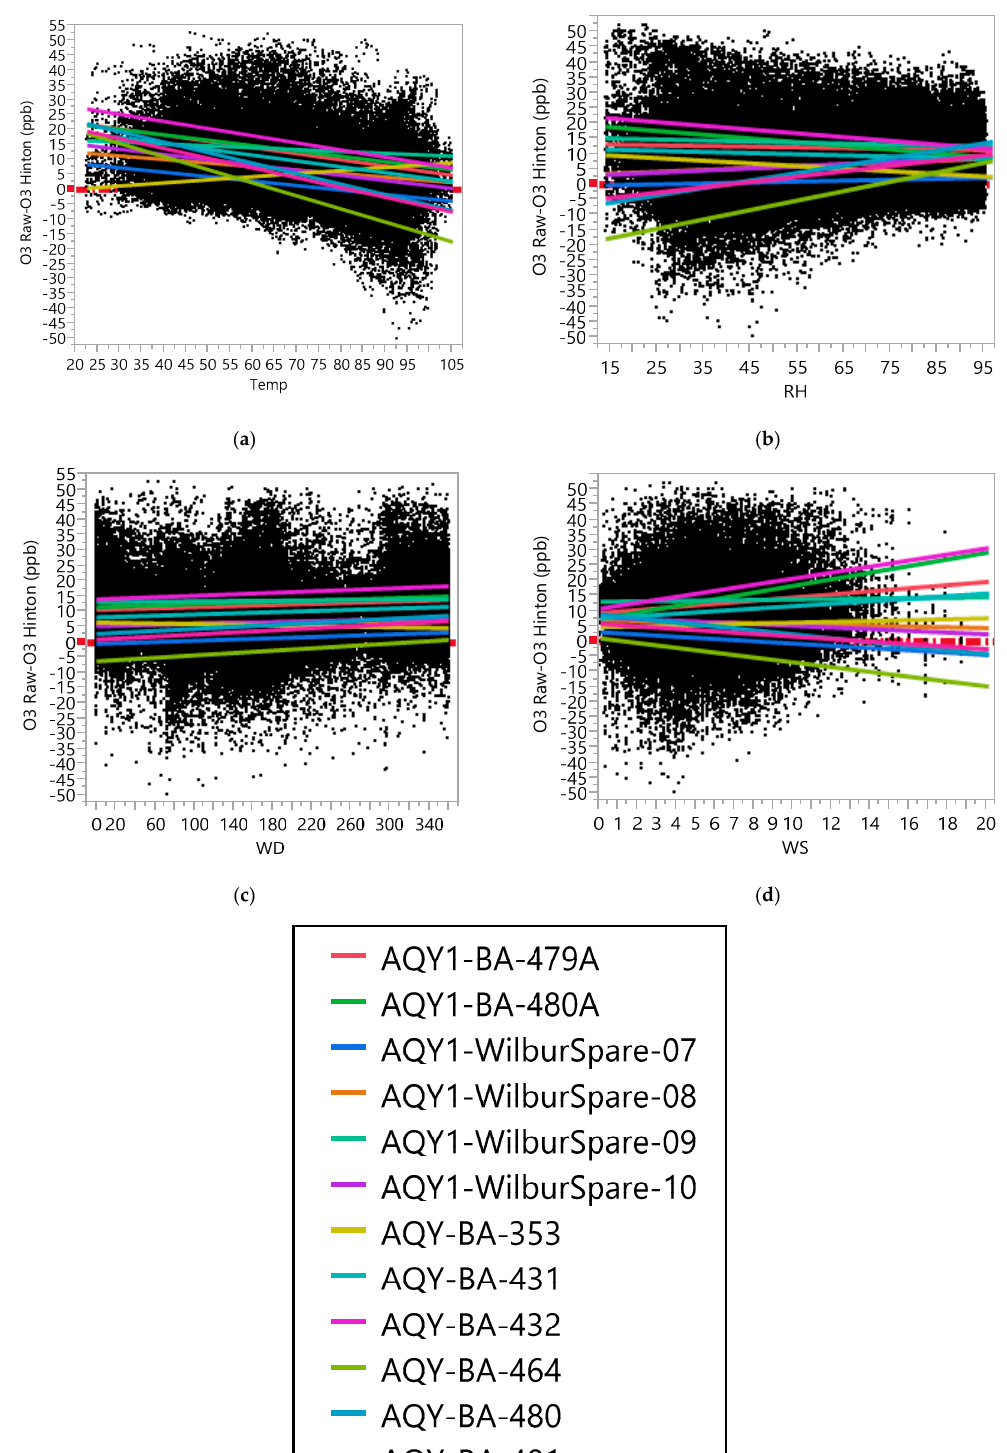
Figure 2. Regression plot between O 3 Raw - O 3 Hinton Data versus ( a ) Temperature, ( b ) RH, ( c ) Wind Direction, and ( d ) Wind Speed, as measured at the Hinton Reference Site.